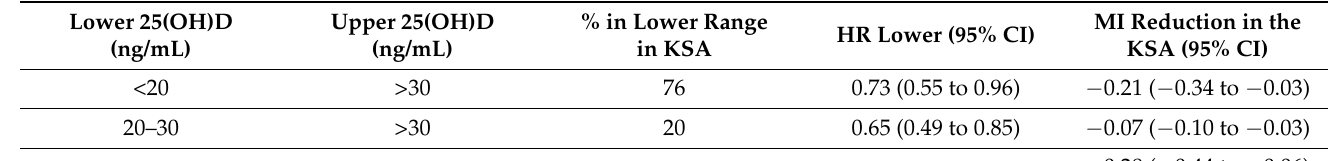
Table 3. Estimate of reduction in MI incidence rate in the KSA by raising minimum 25(OH)D concentration to 30 ng/mL using 25(OH)D data from [86] and results from a U.S. veterans study [80].